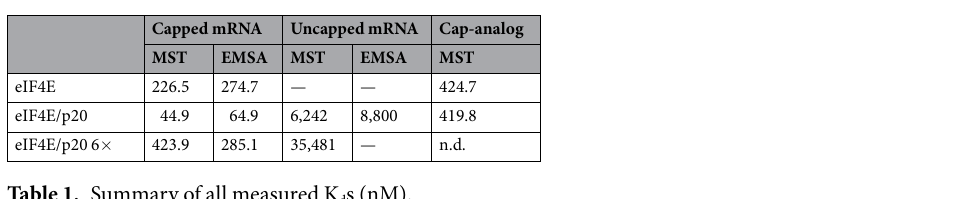
Table 1. Summary of all measured K d s